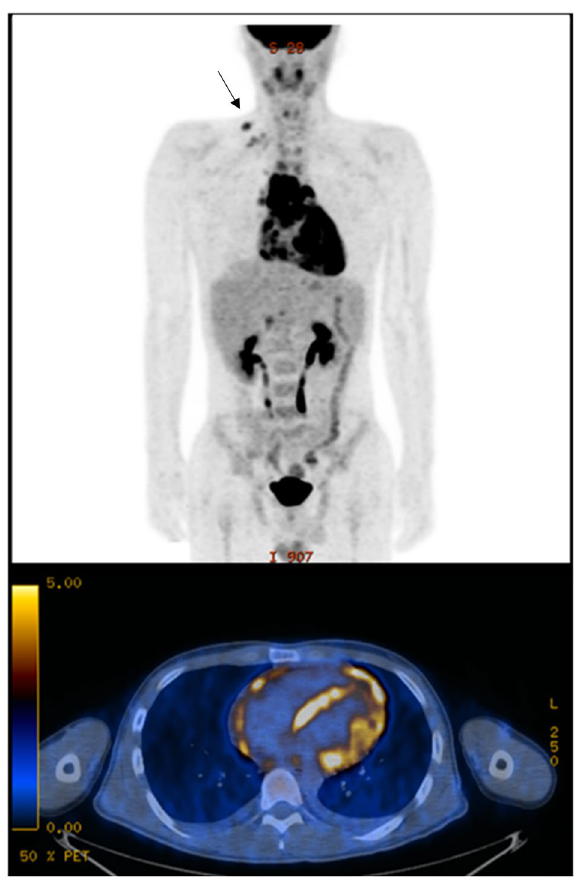
Figure 4. 18 FDG-PET image of a 21-year-old male patient. Tuberculous pericarditis was diagnosed via biopsy right supraclavicular lymph node with increased FDG uptake (black arrow), instead of initially planned pericardial